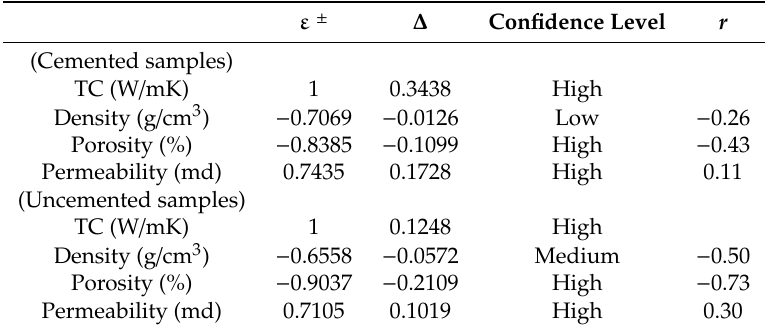
Table 4. Nature of relationships between the factors through the Bidirectional Absolute Grey Relational Analysis (BAGRA)